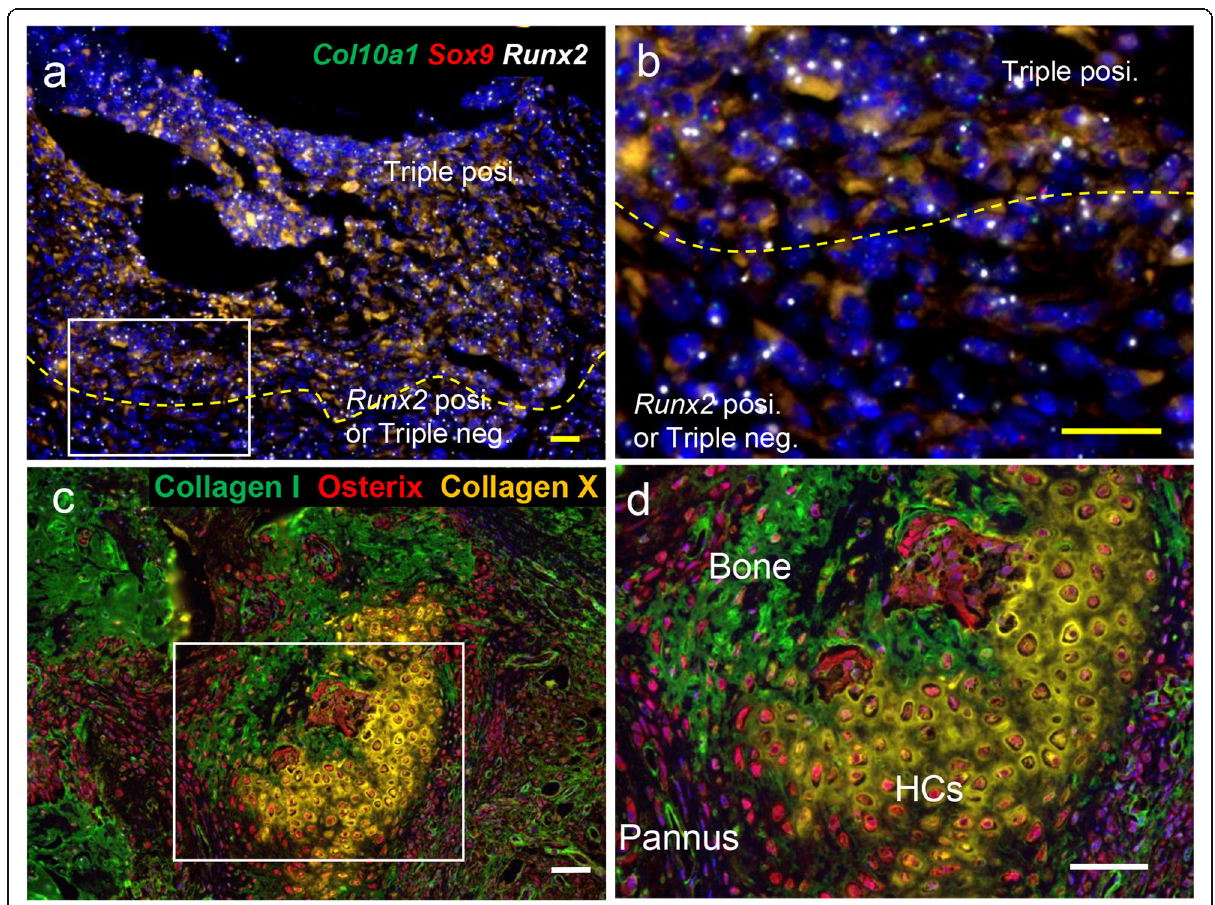
Fig. 3 A subpopulation of SFs expressing Runx2 , Sox9 , and Col10a1 in pannus retain competence as OCs via HCs [16]. a, b In situ hybridization was performed. Sox9 (red), Runx2 (white), and Col10a1 (green) triple-positive synovial fibroblasts are present in pannus, along with Runx2 single- positive and triple-negative ones. c, d Immunohistochemical staining was performed. Osteocytes express ColI (green), and hypertrophic chondrocytes (HCs) express ColX (yellow). Both proteins are detected as extracellular matrix. In addition to pannus, both bone (osteocytes) and HCs express osterix (red). Each box in a and c represents a magnified enlargement area in each right panel. Scale bar = 20 μ m (yellow) and 50 μ m (white)